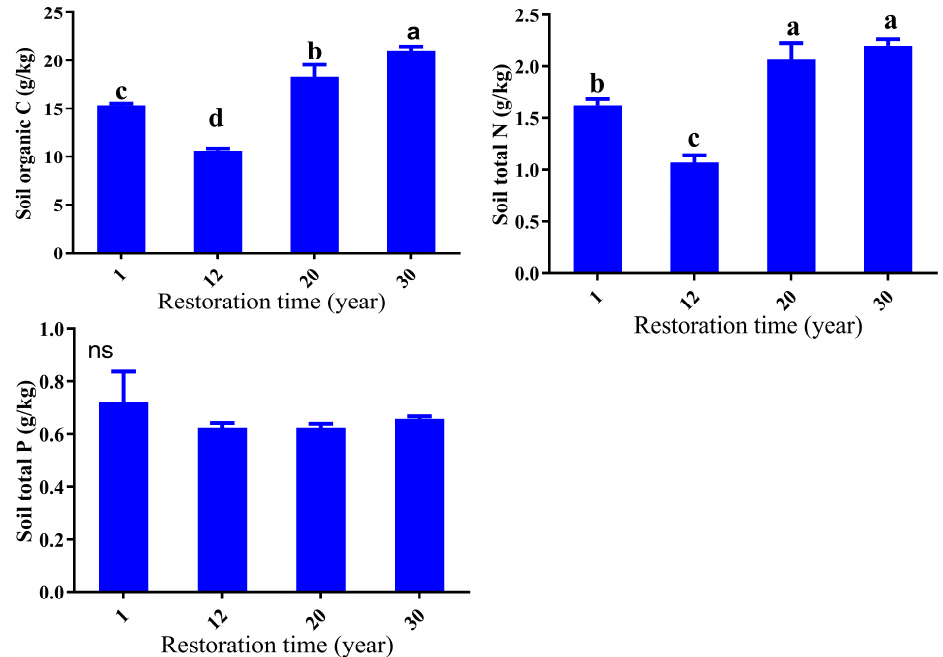
Figure 3. Soil organic carbon (SOC), soil total nitrogen (STN), and soil total phosphorus (STP) across different succession stages. Different letters indicate significant differences between vegetation sites ( p < 0.05), ns indicated that there was no significant difference for STP across the succession.